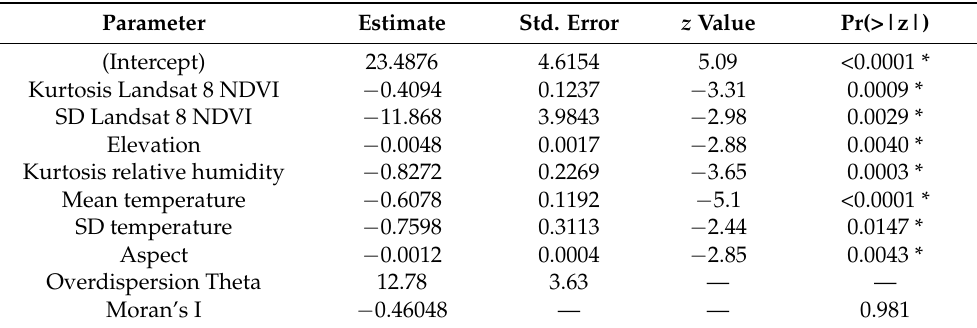
Table 4. Parameter estimates for the best negative binomial model explaining Tripteroides bambusa fourth instar larvae abundance at Mt. Konpira, Nagasaki, Japan.